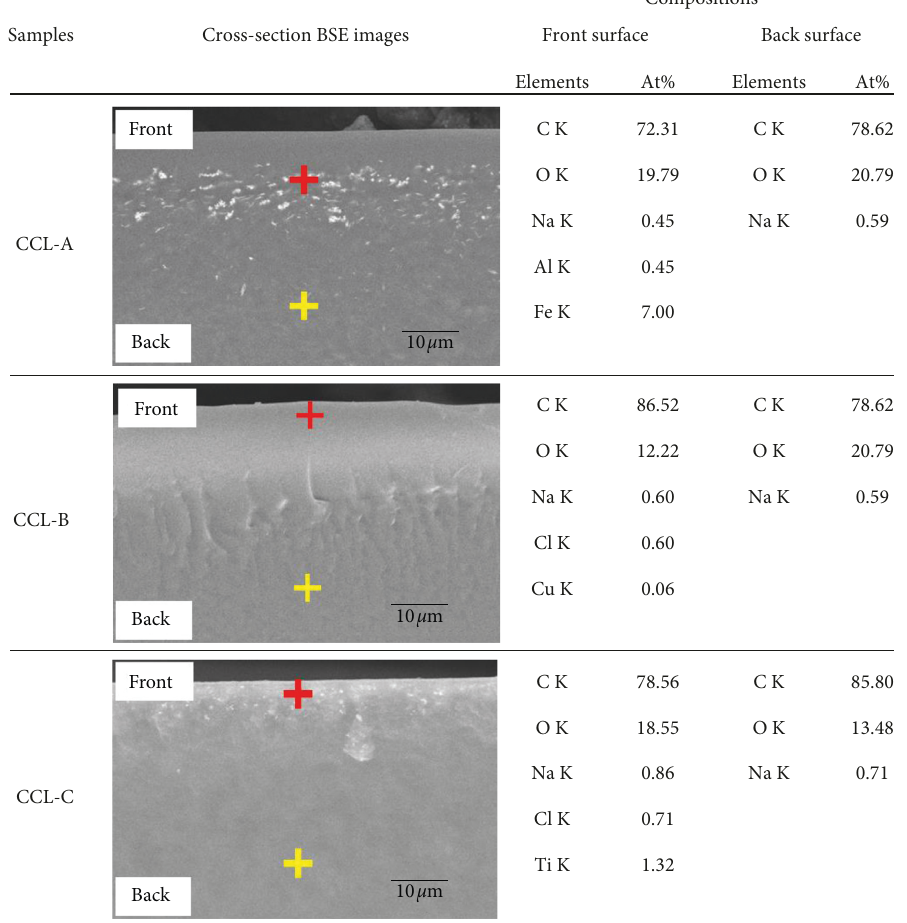
Figure 3: Cross-sectional BSE images and analyses of compositions by SEM-EDX. The crosses represent the EDX analysis points, with red crosses for colored layer points and yellow crosses for the noncolored